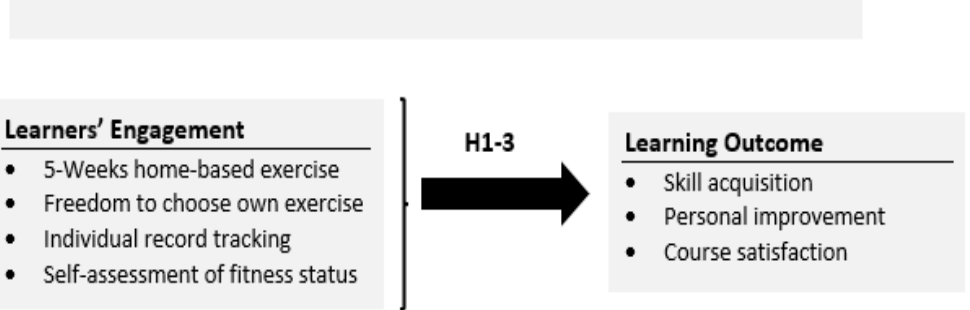
Figure 1. Conceptual framework of the study.